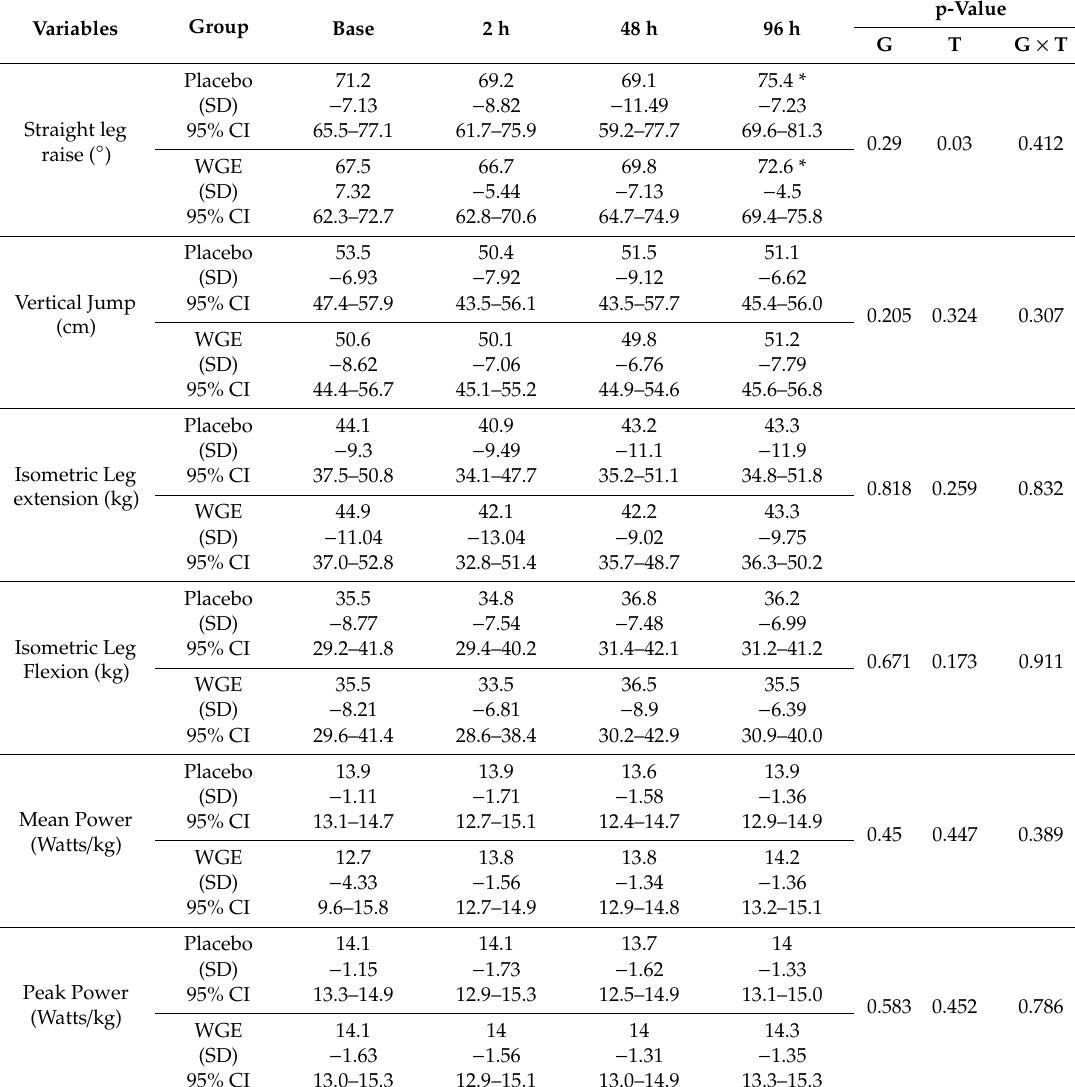
Table 4. The results of physical performance following acute eccentric